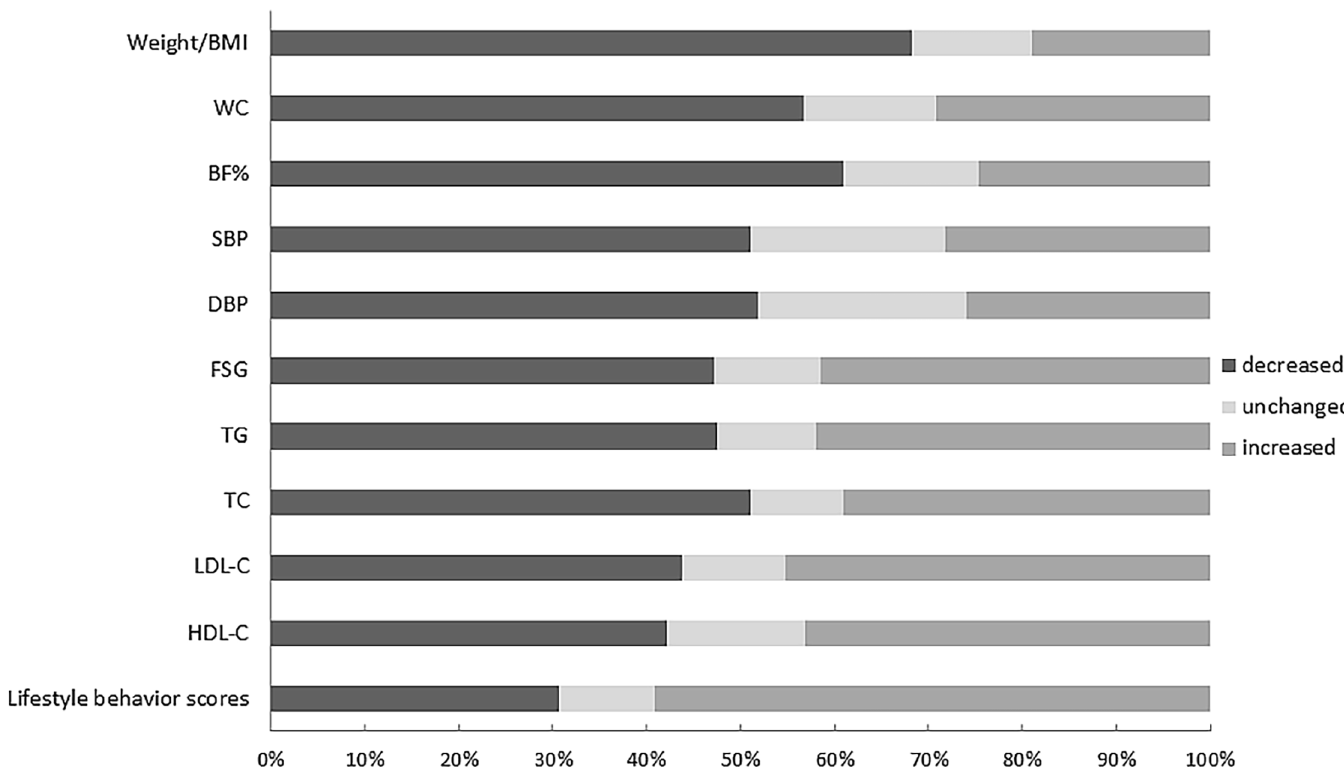
Fig 2. The proportion of changing state after 3-month intervention among the overweight and obesity group. Abbreviation: BMI, body mass index; WC, waist circumference; SBP, systolic blood pressure; DBP, diastolic blood pressure; BF %, body fat percentage; FSG, fasting serum glucose; TG, triglyceride; TC, total cholesterol; LDL-C, low density lipoprotein-cholesterol; HDL-C, high density lipoprotein-cholesterol.